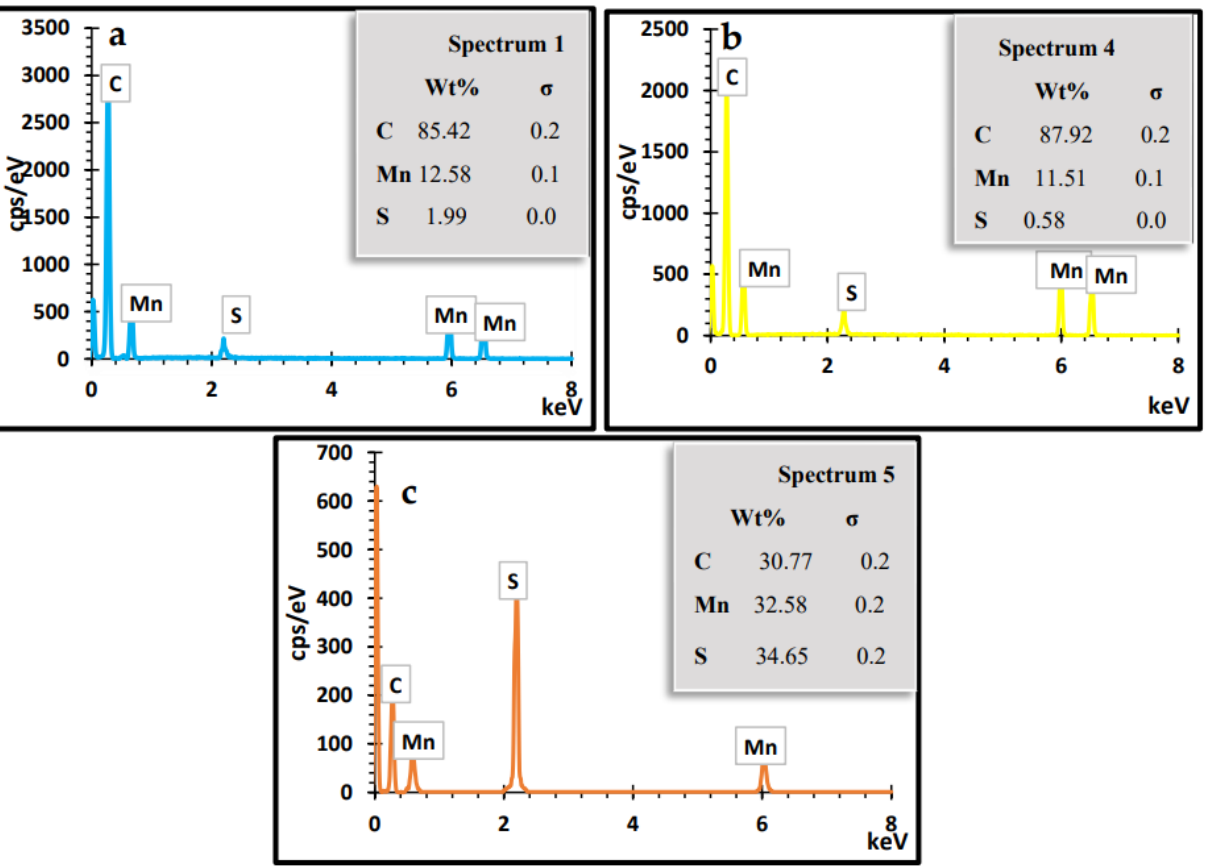
Figure 8. EDS spectra of MnS_1 ( a ), MnS_2 ( b ) and MnS_3 ( c ) nanoparticles.